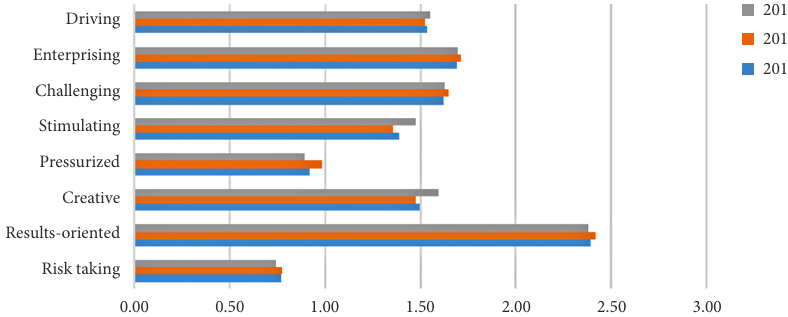
Figure 2. Innovative culture characteristics according to Wallach (1983) (source: Prepared by the authors)